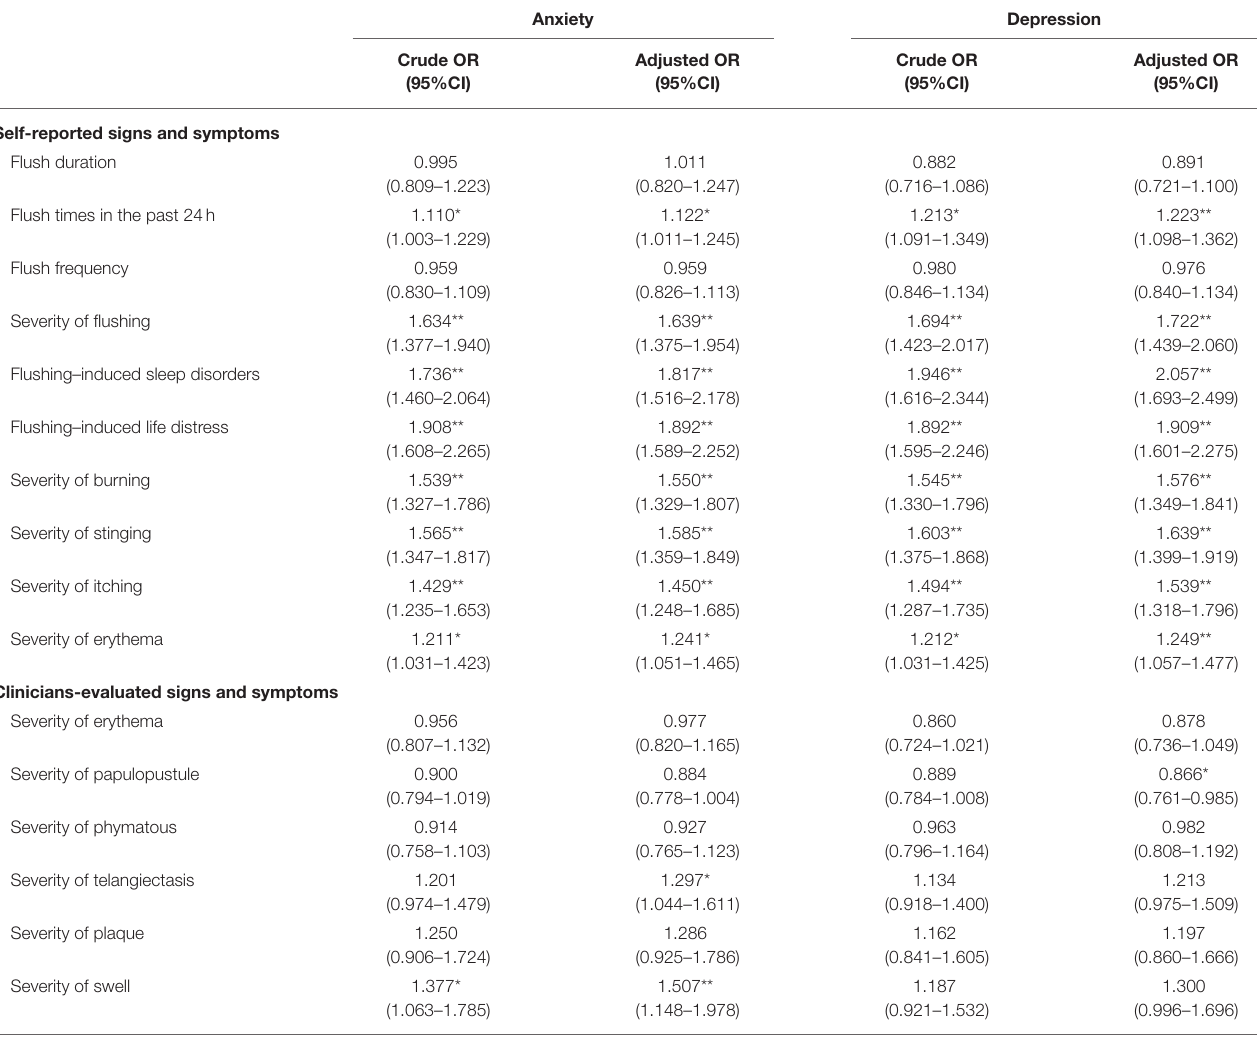
TABLE 2 | Self-reported and clinician-evaluated signs and symptoms associated with anxiety or depression (demographic data